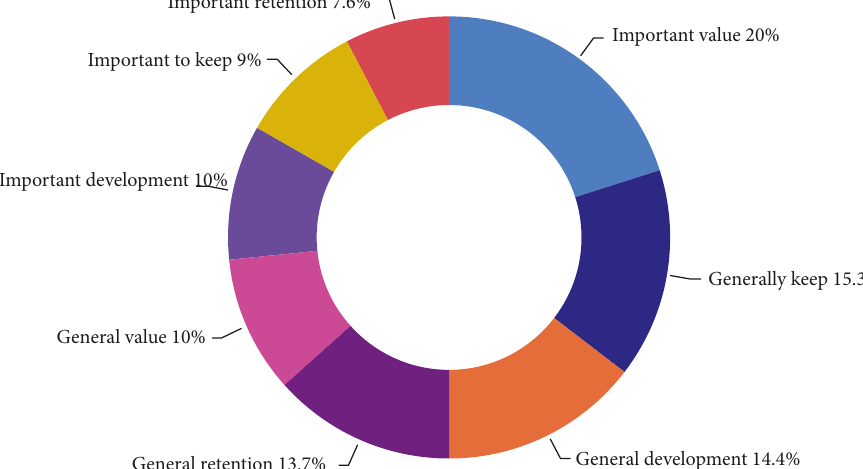
Figure 6: User classification results of this paper.